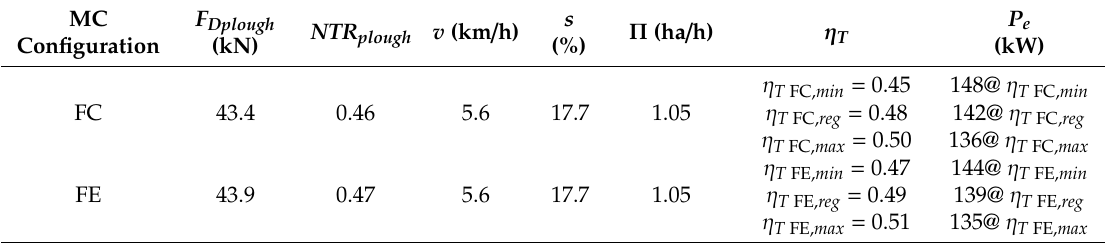
Table 10. Fundamental parameters of the cost-e ff ectiveness analysis during